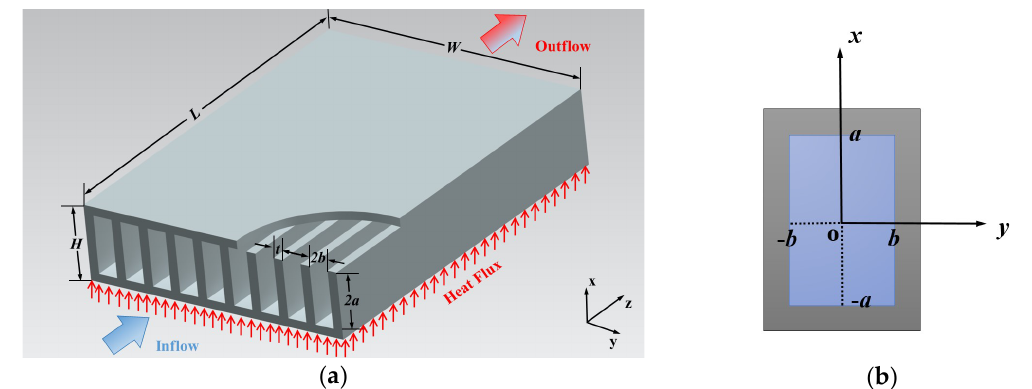
Figure 1. Schematics of the microchannel plate fin heat sink. ( a ) Microchannel plate fin heat sink; ( b ) Computational unit.